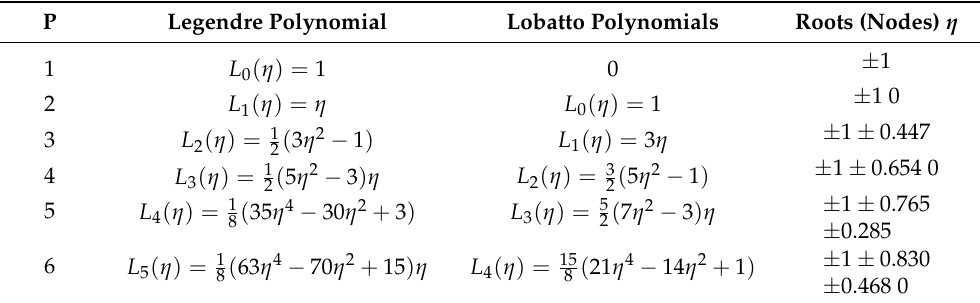
Table 1. Six Legendre polynomials ( L ), Lobatto polynomials of order p − 1, and roots (nodes) η . P Legendre Polynomial Lobatto Polynomials Roots (Nodes) η